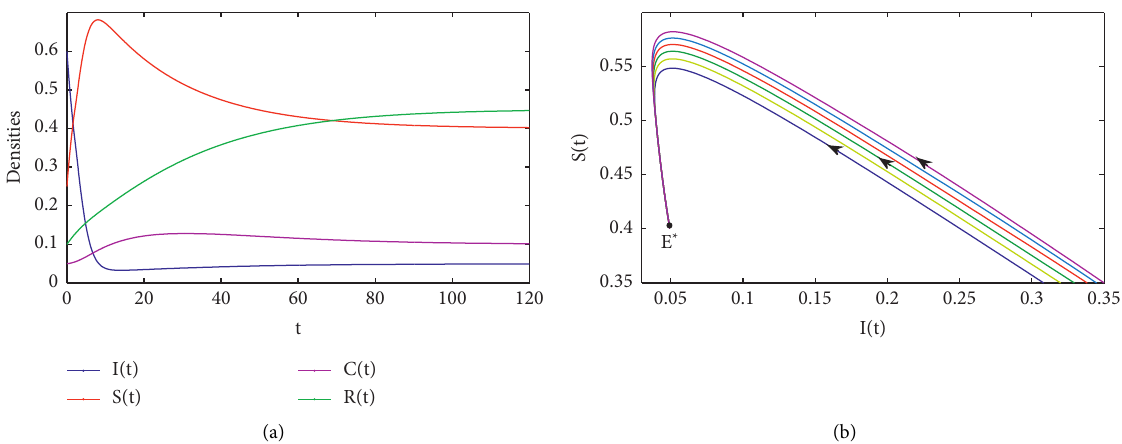
Figure 3: The stability of rumor-prevailing equilibrium E ∗ when R